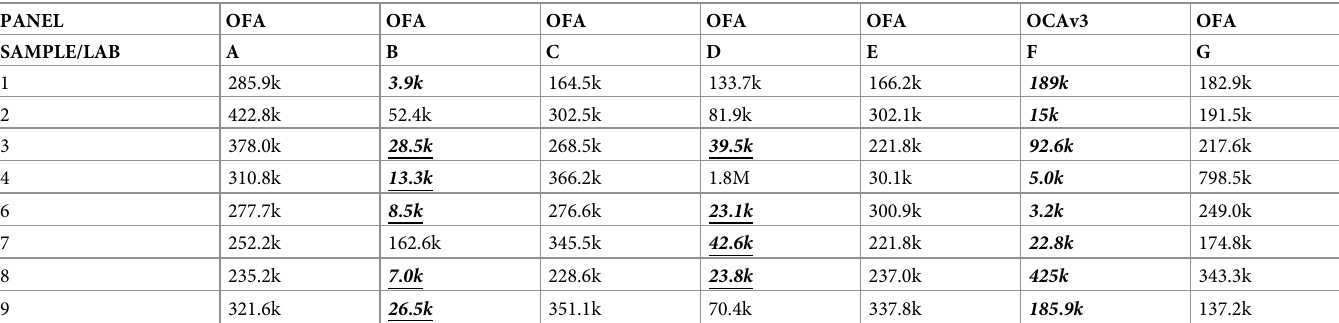
Table 11. Phase 2 RNA total mapped read values.